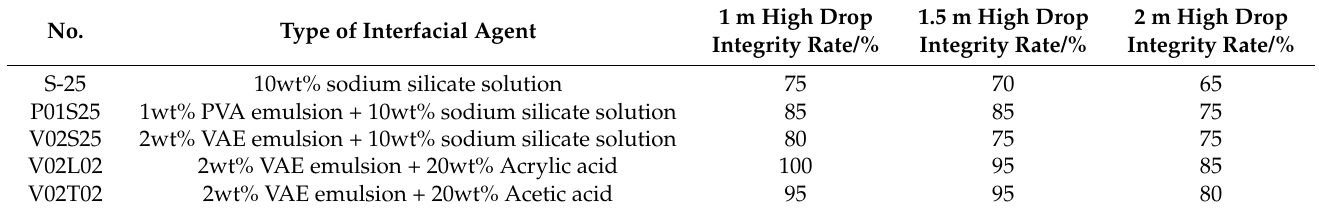
Table 6. Type of interfacial agent and forming performance of CSLA.